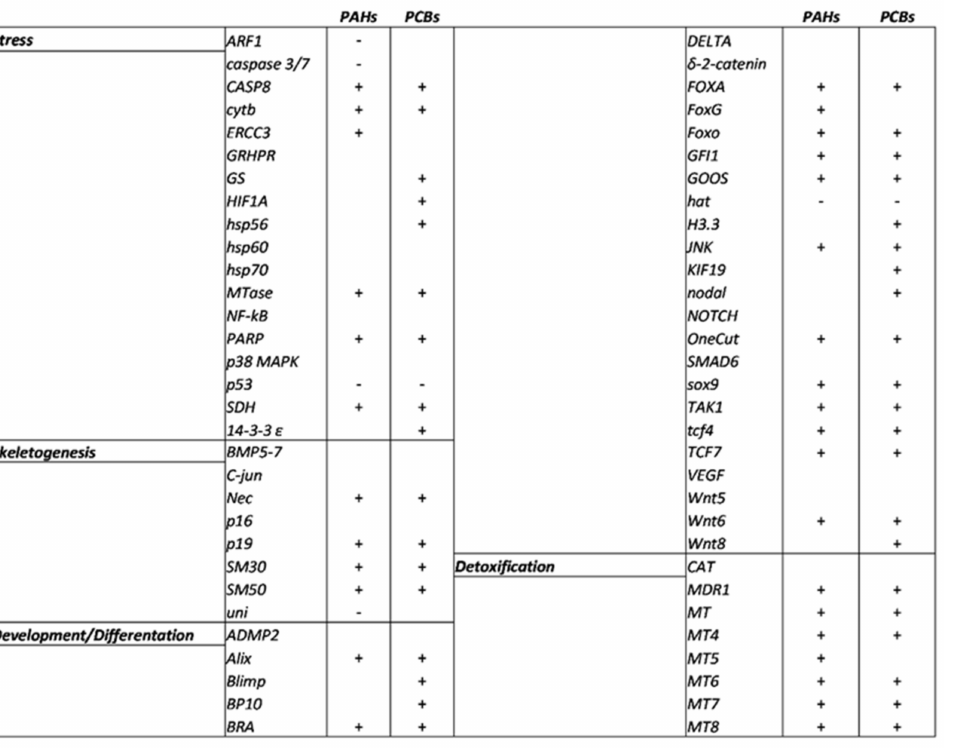
Figure 5. Schematic overview of P. lividus genes affected by artificial contaminated sediment with PAHs and PCBs under analysis. + = up-regulated gene; - = down-regulated